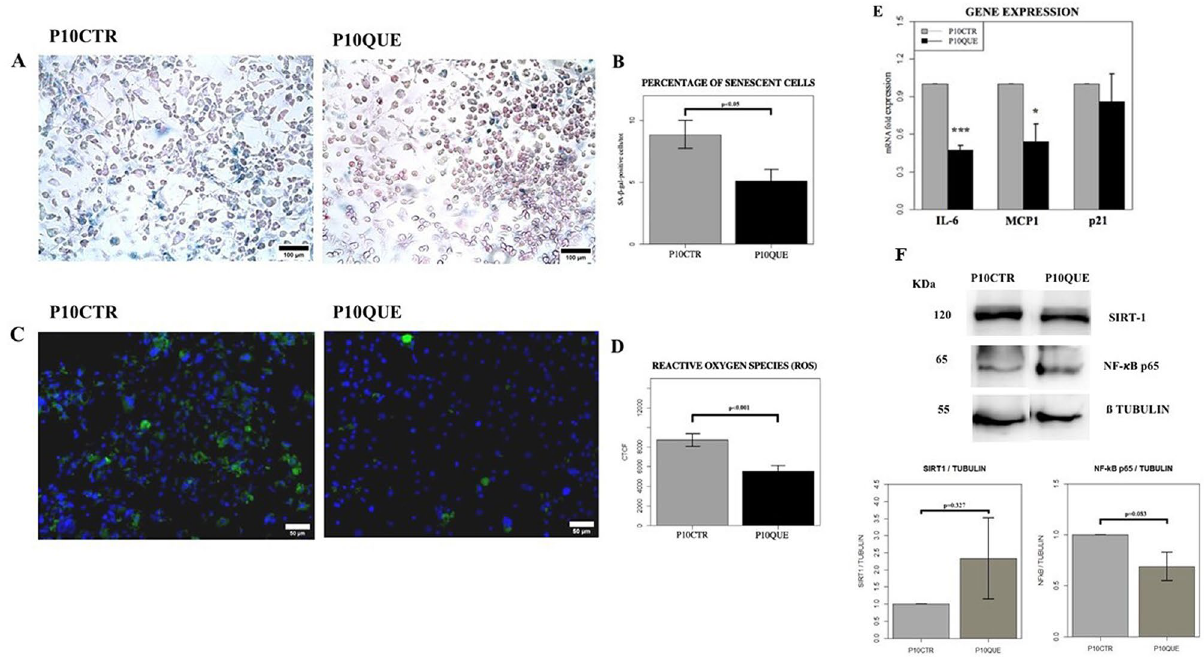
Figure 2. Analyses on 3T3-L1 cells treated with quercetin 20 μM 5 days after the induction (at PID5) on alternate days for a total of three times; cells were analyzed at PID10. ( A ) Evaluation of the adipocyte’s senescence with the specific staining for β-galactosidase. Representative images of cell senescence in adipocytes at PID10 (P10CTR) and PID10 treated with 20 μM quercetin (P10QUE). Scale = 100 μm. ( B ) Histograms showing the percentage of senescent cells among adipocytes (P10CTR) and adipocytes treated with 20 μM quercetin (P10QUE), at the 10th day after induction. The values are represented as mean ± SE. ( C ) Significant images of the accumulation of intracellular ROS (in green) in 3T3-L1 fat cells at PID10 (P10CTR) and PID10 treated with 20 μM quercetin (P10QUER). Scale = 50 μm. ( D ) Histograms showing the amount of ROS among adipocytes (P10CTR) and adipocytes treated with 20 μM quercetin (P10QUE), at the 10th day after induction. The values are represented as mean ± SE. PID = post induction day, ROS = Reactive oxygen species. ( E ) Gene expression profile of adipocytes at PID10 (P10CTR) and adipocytes treated with quercetin (P10QUE) at PID10. * p < 0.05, ** p < 0.01, *** p < 0.001. IL-6 = interleukin-6, MCP1 = monocyte chemoattractant protein 1, p21 = cyclin-dependent kinase inhibitor 1. ( F ) Cropped blots and densitometric analysis from western blotting assay of SIRT1 and NF-κB p65 normalized on β-tubulin, in total extracts of adipocytes at PID10 (P10CTR) and adipocytes at PID10 treated with quercetin (P10QUE). The values are represented as mean ± SE. SIRT1 = silent regulator information 1, NF-κB = nuclear factor kappa-light-chain-enhancer of activated B cells. For full length membranes please refer to Supplementary Fig. 2A,